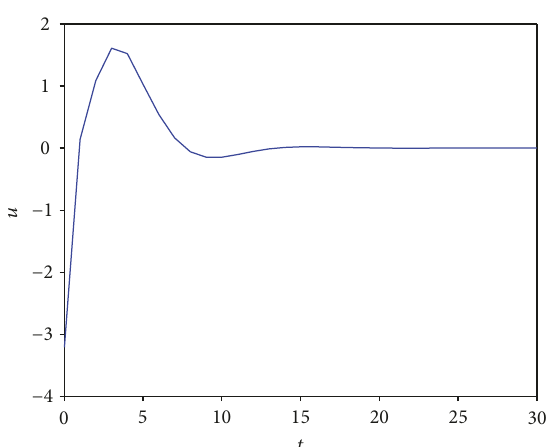
Figure 3: Time response of the control input under observer-based fuzzy